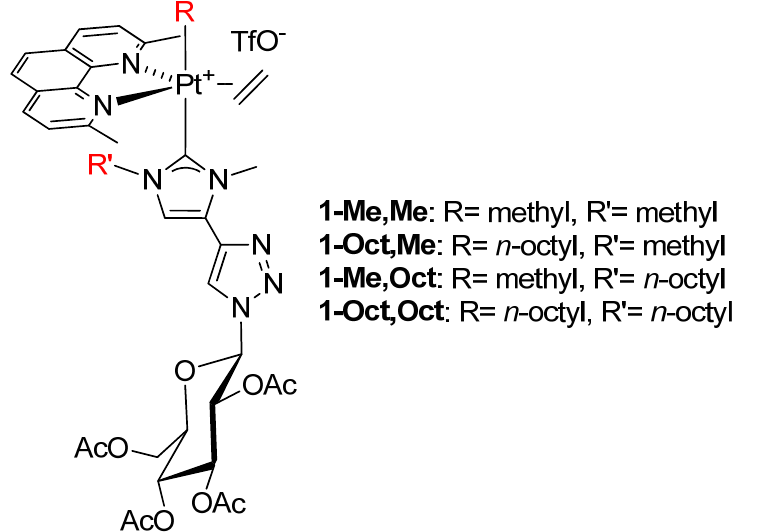
Figure 2. Structure of the complexes prepared within this